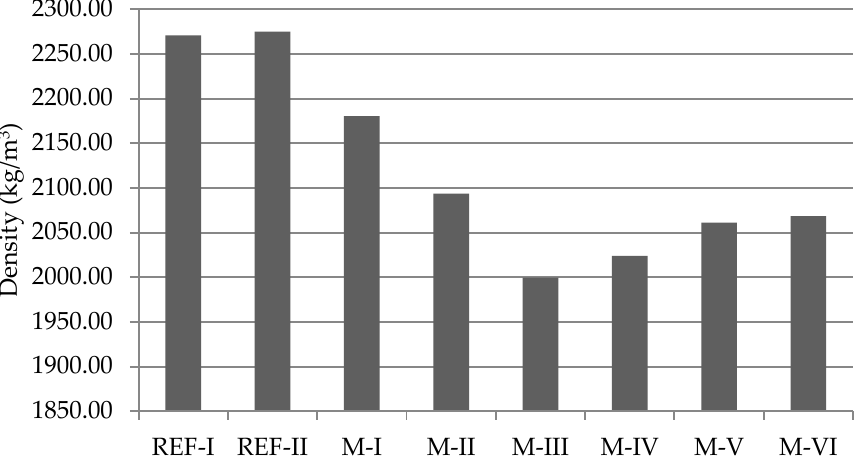
Figure 5. Density of mortar specimens.